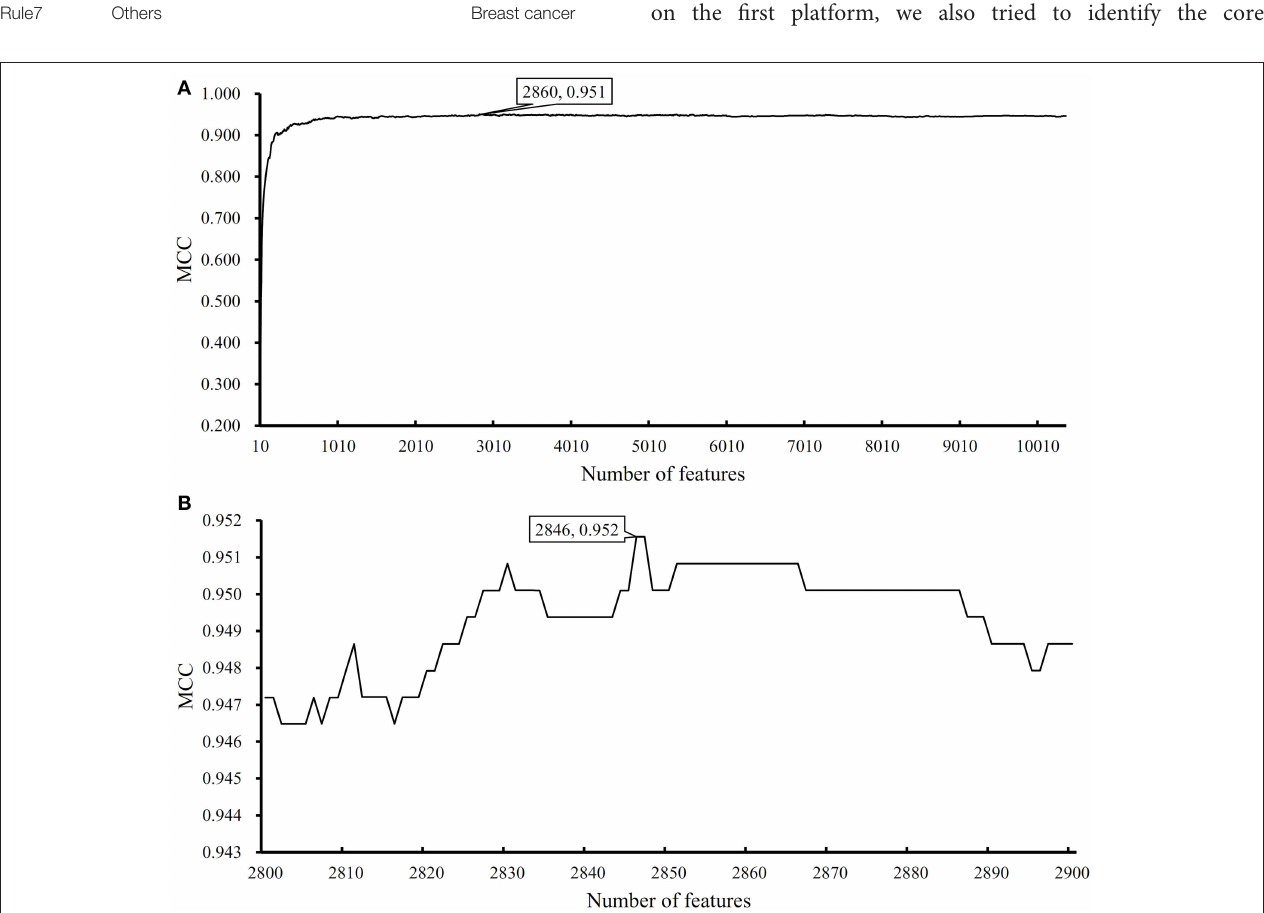
FIGURE 5 | Performance of support vector machine (SVM) on different feature subsets. (A) Performance of SVM on feature subsets with step 10; (B) Performance of SVM on feature subsets with top 2,800–2,900 features.